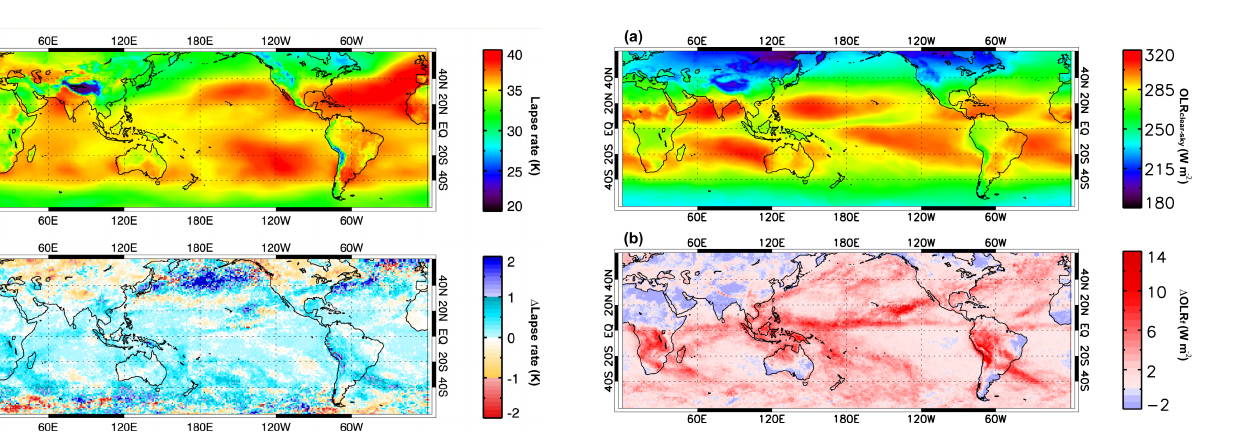
Fig. 2. Geographic distributions of one-month (15 December 2006– 15 January 2007) means of (a) lapse rate and (b) lapse rate differ- ence between cloud-free OLR and clear-sky OLR. The lapse rate is defined as the mean temperature difference between two layers (surface to 500hPa layer, and 500hPa to 200hPa layer).